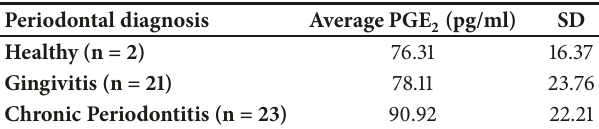
levels by periodontal Table 2: PGE 2